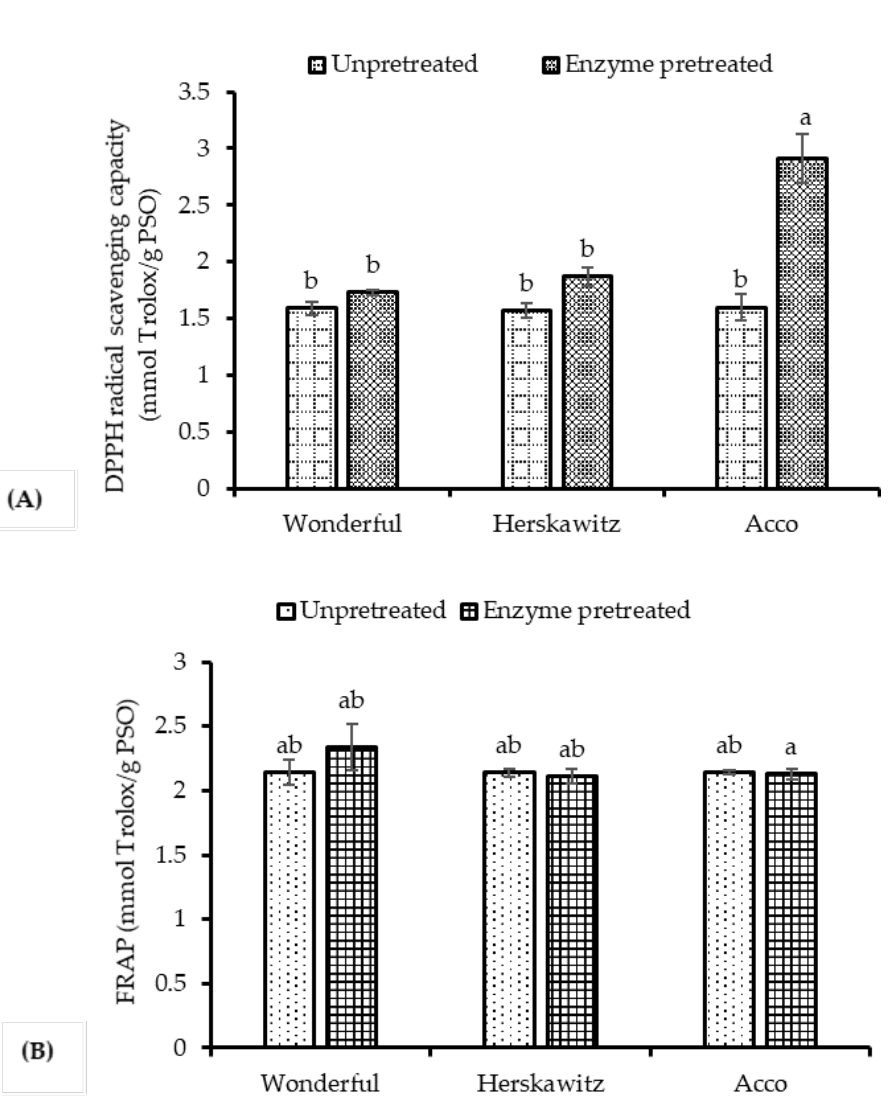
Figure 5. ( A ) DPPH radical scavenging capacity and ( B ) ferric reducing antioxidant power (FRAP) of un-pretreated and enzyme pretreated seeds (1.7%, 40 ◦ C, pH = 4.5 and 5 h) from studied pomegranate cultivars. Within the same cultivar (un-pretreated and enzyme pretreated), columns followed by different letters are significantly different ( p < 0.05), according to Duncan’s multiple range test. Vertical bars indicate the standard deviation of the mean.